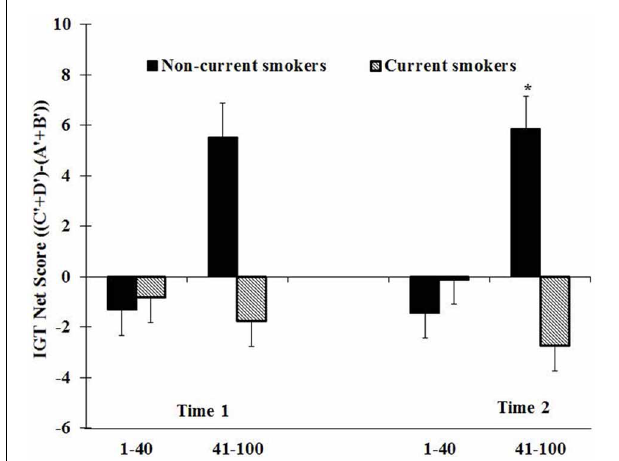
FIGURE 1 | The IGT net scores [(C (cid:2) + D (cid:2) ) – (A (cid:2) + B (cid:2) )] by smoking status (non-current and current smokers) across first (1–40) and latter (41–100) blocks expressed as mean + S.E. after controlling for age, gender, school type, and school academic performance. Positive net scores reflect advantageous (non-impaired performance) while negative net scores reflect dis advantageous (impaired) performance. *Comparing between groups. ∗ P < 0 .